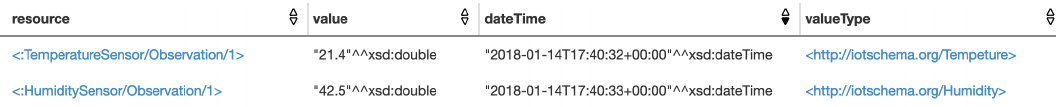
Figure 7. The result of the example SPARQL query, all the Alice’s home environment resources that were modeled as lhr:EnvResource are retrieved with their data value, data time, and value